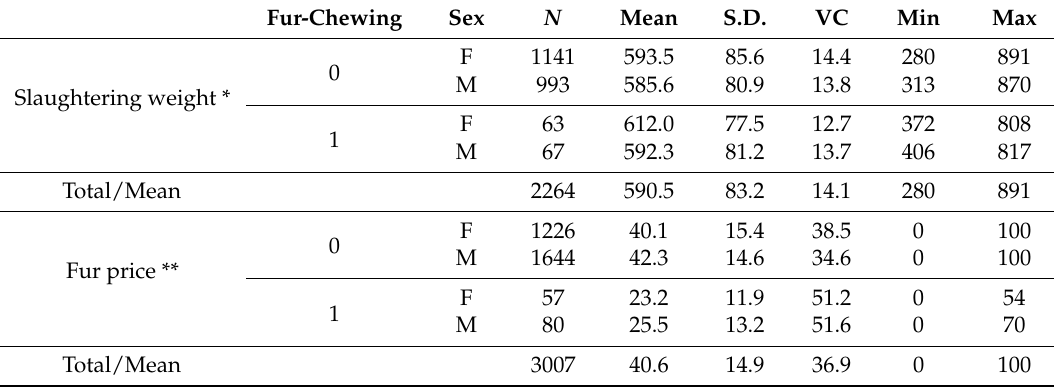
Table 1. Number of observations ( N ), mean, standard deviation (S.D.), variation coefficient (VC), minimum value (Min) and maximum value (Max) for each trait, considering fur-chewing (0 = not fur-chewer; 1 = fur-chewer) and sex (F = female; M = male) as categories. Fur-Chewing Sex N